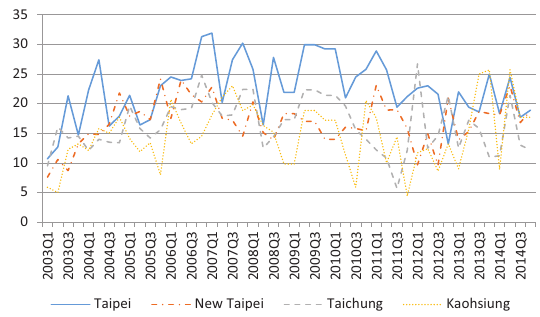
Figure 4. The proportion of buyers who purchased housing for